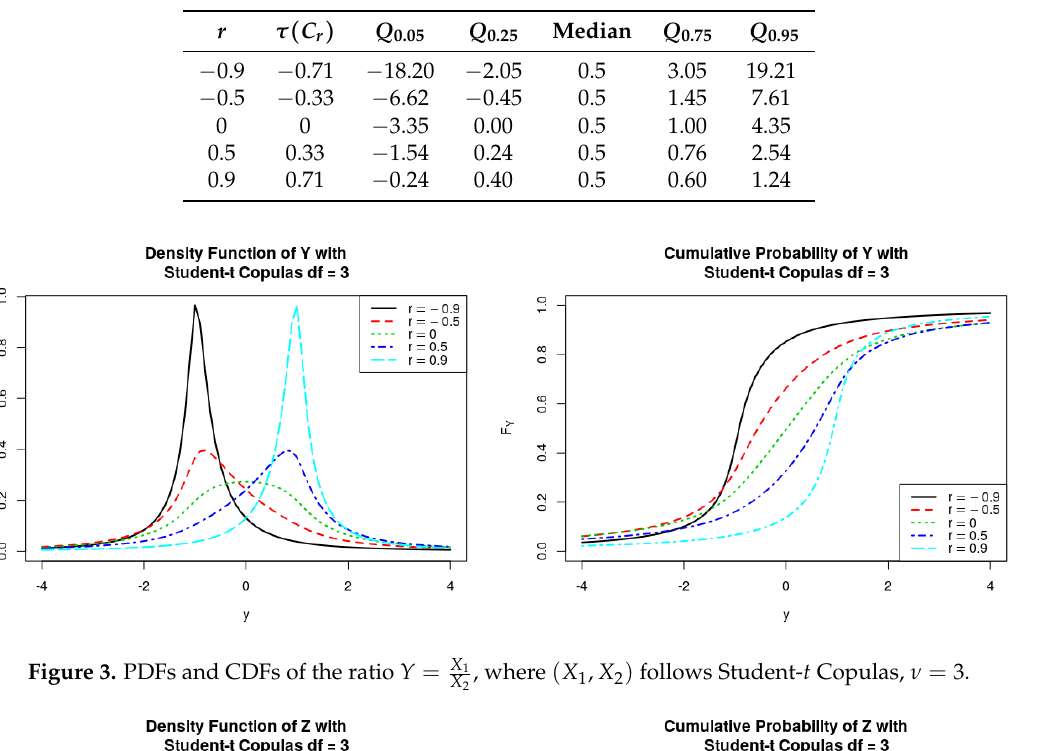
, where ( X 1 , X 2 ) follows Student- t Copulas, ν = 3. X 2